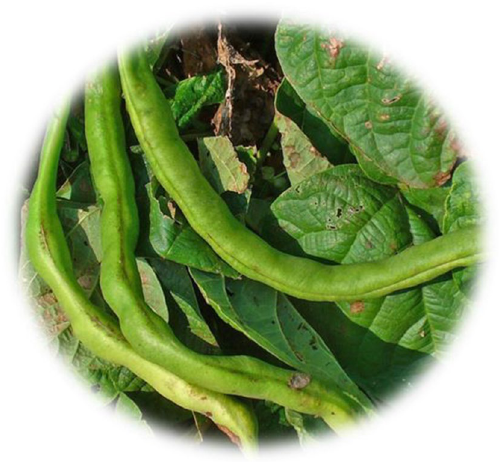
Fig. 17 Poly-galacturonic acid structure present in the mucilage of opuntia